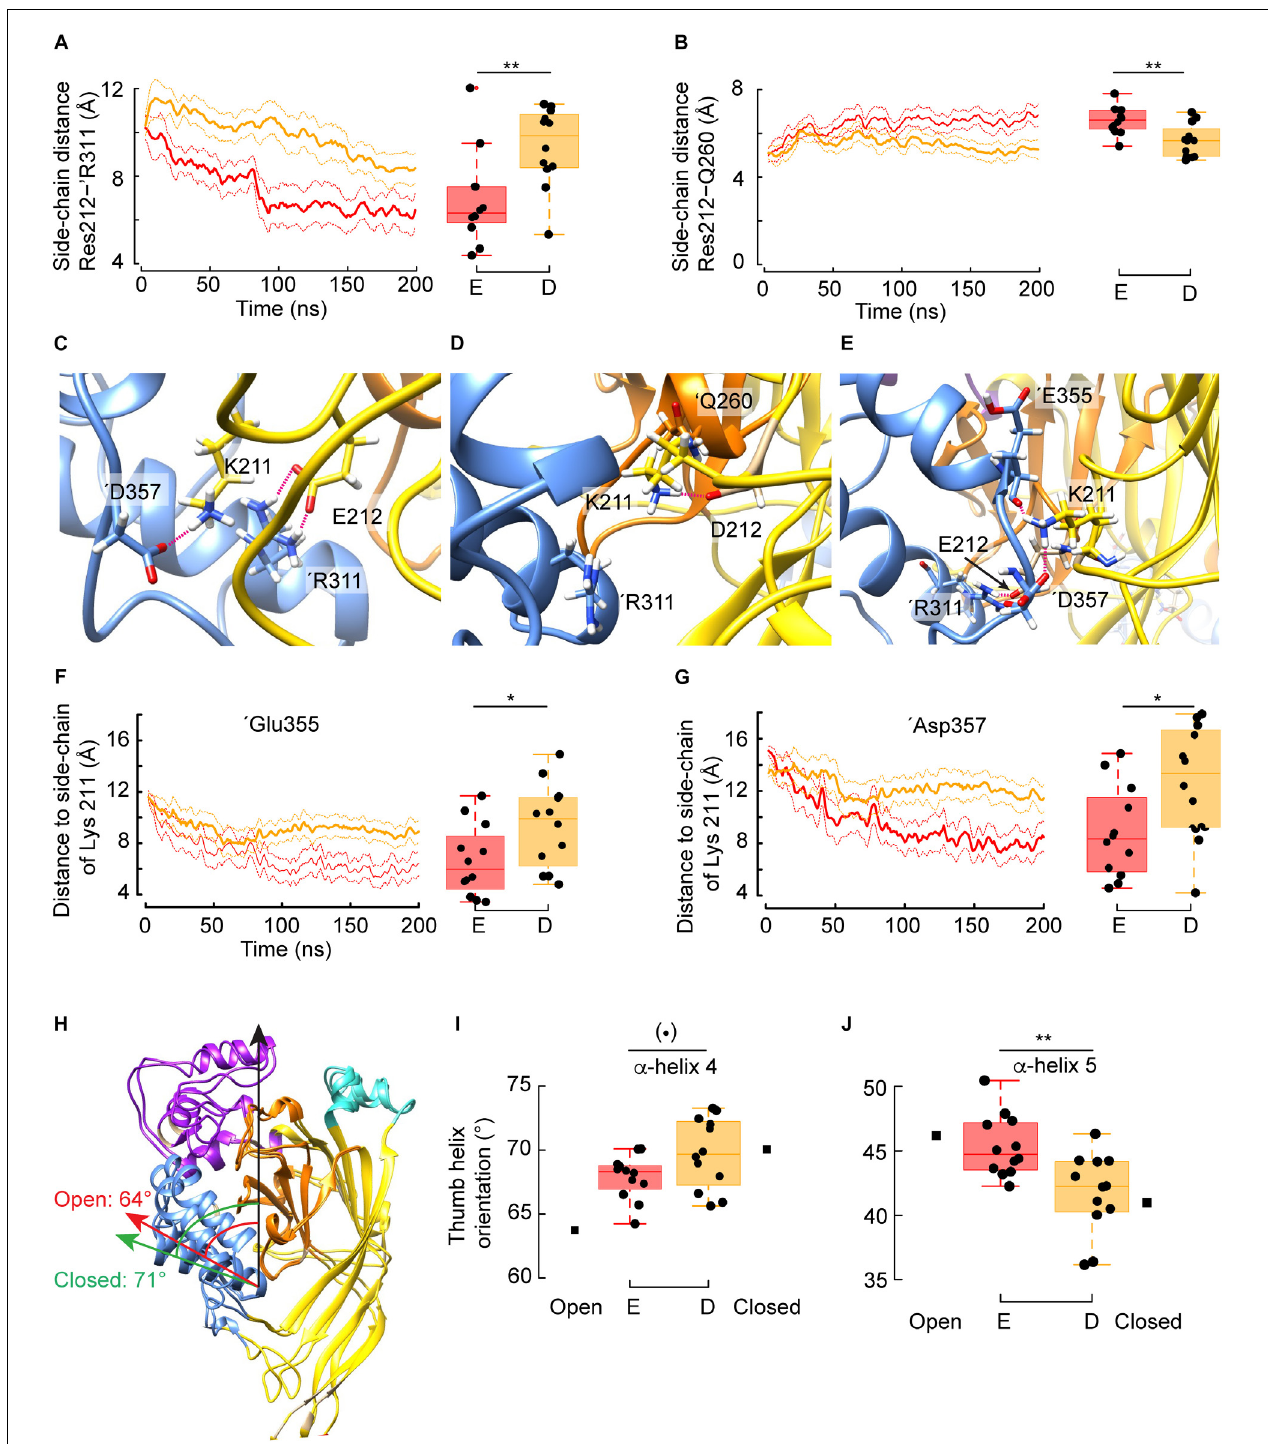
FIGURE 4 | Mechanism by which Glu but not Asp at position 212 favors channel opening. (A) Averaged time series of the distance between the guanidium group of ’Arg311 and the carboxylic group of Glu212 (red) or Asp212 (orange). Right: Corresponding quantification over the whole trajectory (first 20 ns discarded). Glu212: n = 12, 4 independent simulations, Asp212: n = 9, 3 independent simulations. (B) Averaged time series of the distance between the side chain of Gln260 and the carboxylic group of Glu212 or Asp212. Right: Corresponding quantification over the whole trajectory (first 20 ns discarded). (C) Typical molecular representation in the context of a simulation with G212E, in which Glu212 and ’Arg311 form two salt bridges, while Lys211 interacts with ’Asp357. (D) Typical molecular